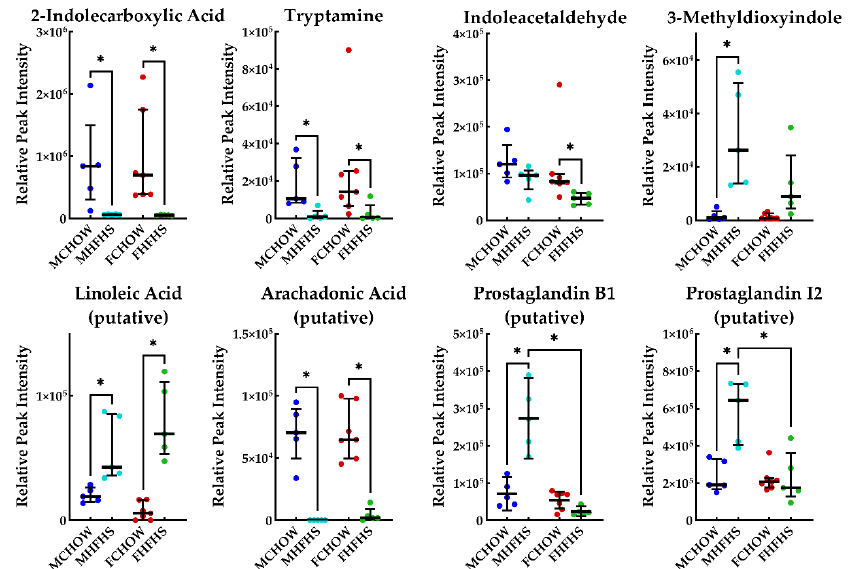
Figure 4. Inflammation Related Metabolites. Horizontal bars represent the median relative peak intensity of each metabolite with the interquartile range. * p < 0.01. MCHOW vs. FCHOW, MCHOW vs. FHFHS, and MHFHS vs. FHFHS groups were not compared.